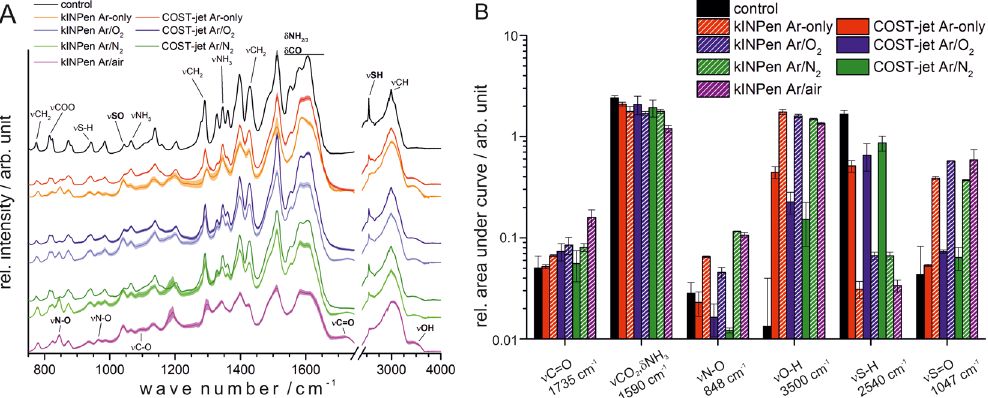
Figure 2. FTIR spectroscopy ( A ) and peak quantification ( B ) of Ar-based plasmas using both sources. Spectra were recorded after 10 min of treatment. Bold annotations were used for quantification. “Control” samples were treated with Ar gas only. The graphs are stacked for better